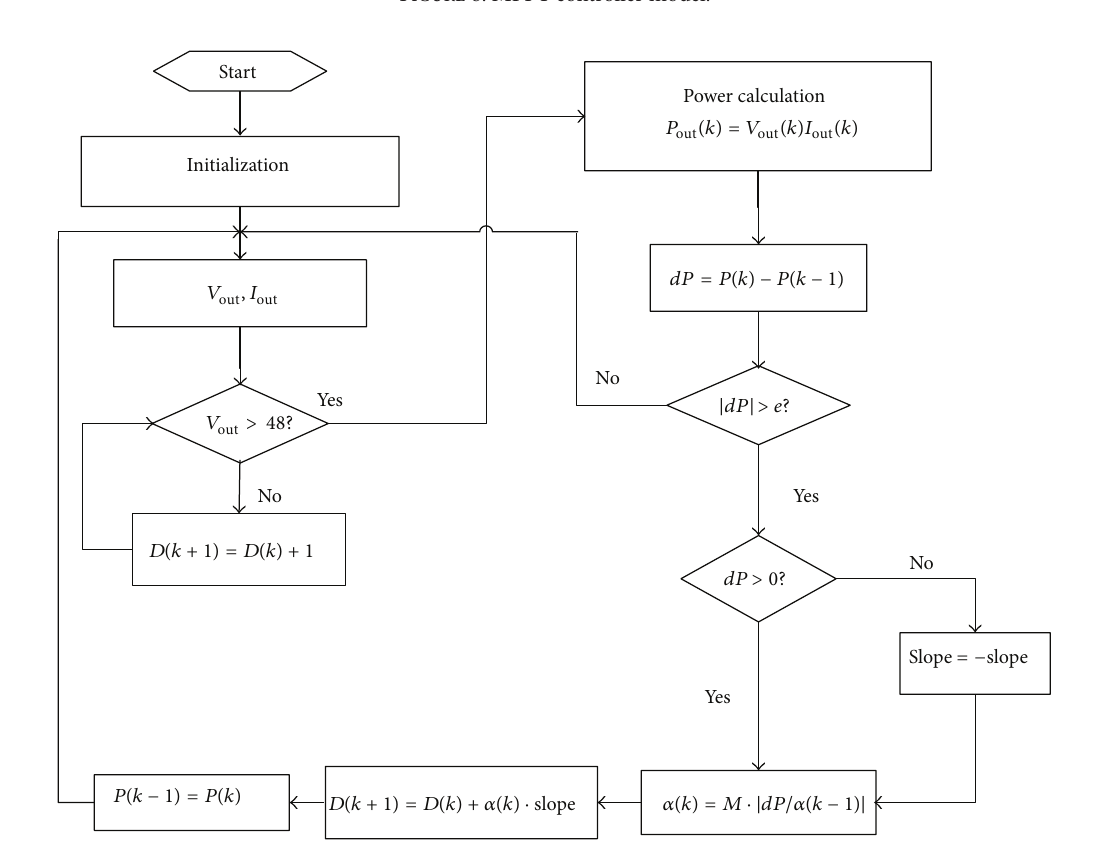
Figure 9: Flow chart of control strategy for